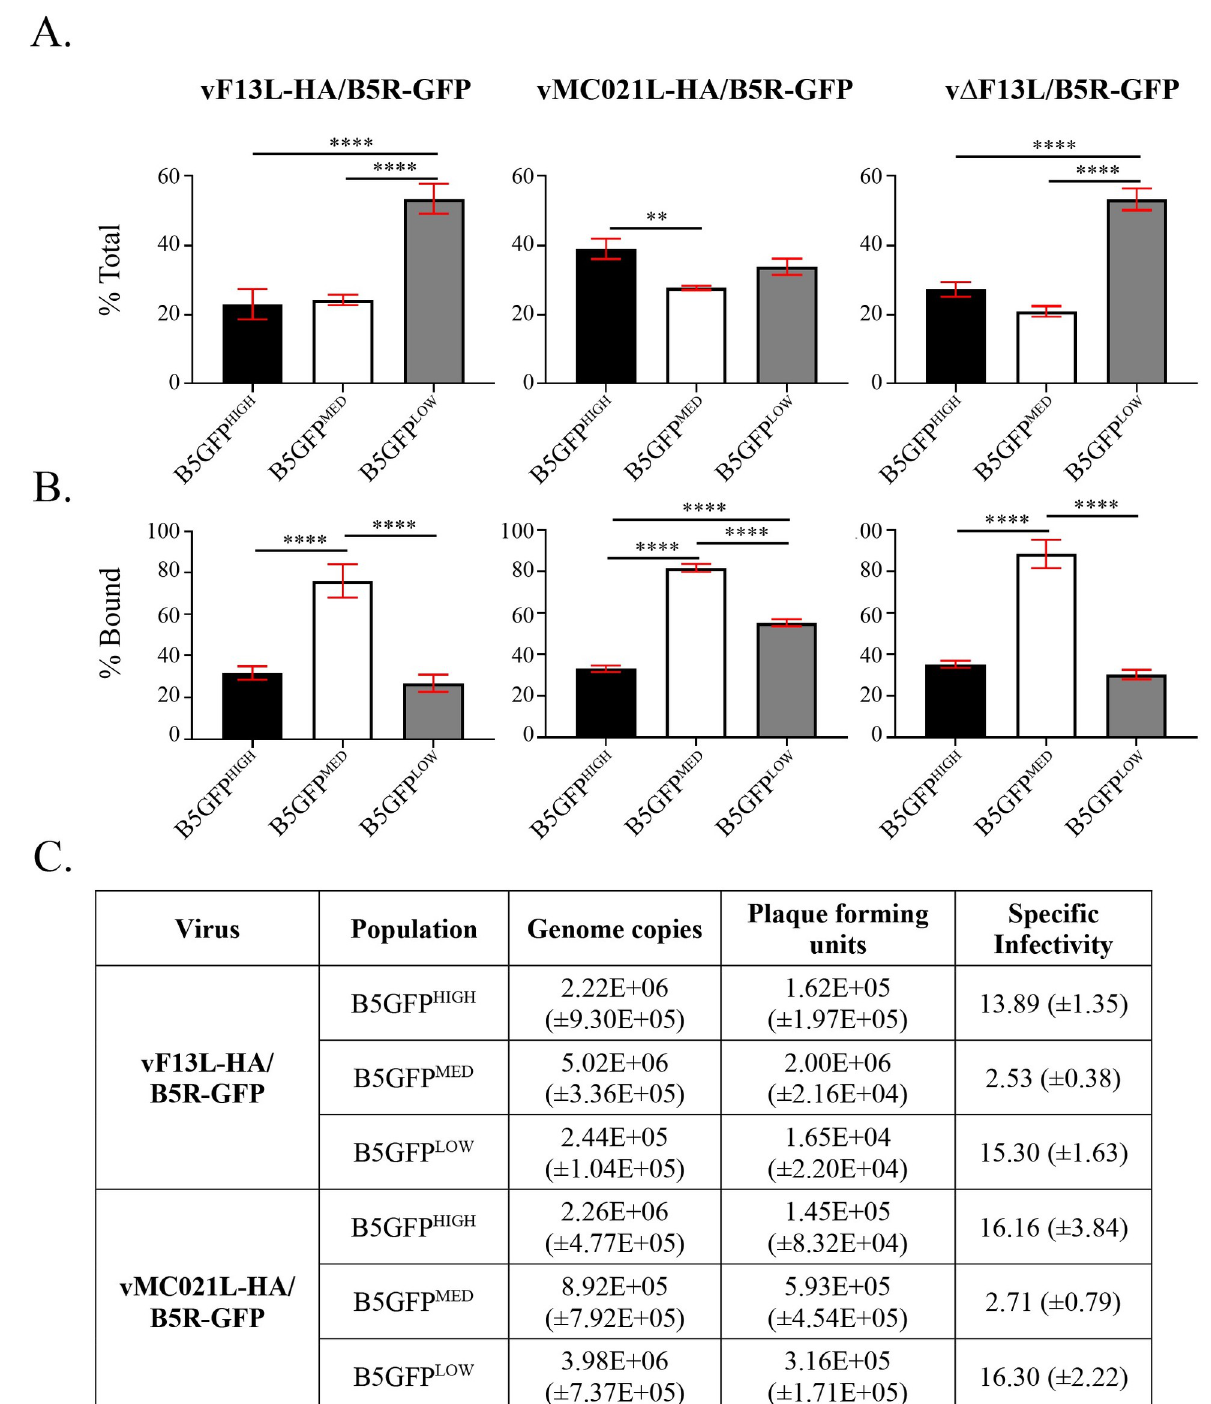
Fig 4. Fluorescence activated virion sorting and infectivity assays. RK13 cells were infected with the indicated viruses at a MOI of 5 and incubated at 37˚C overnight. The next day, progeny virions released into the media (EV) were centrifuged through a sucrose cushion, and analyzed by fluorescence-activated virion sorting. EV virions were sorted into 3 pools based on GFP fluorescence intensity (B5GFP HIGH , B5GFP MED , and B5GFP LOW ) and subsequently analyzed by qPCR for (A) total genome copies and (B) cell binding. (C) Specific infectivity was calculated by comparing total genome copies (by qPCR) and plaque forming units (by plaque assay). �� , p < 0.01 and ���� , p < 0.001 by Tukey’s multiple comparison test following one-way ANOVA.